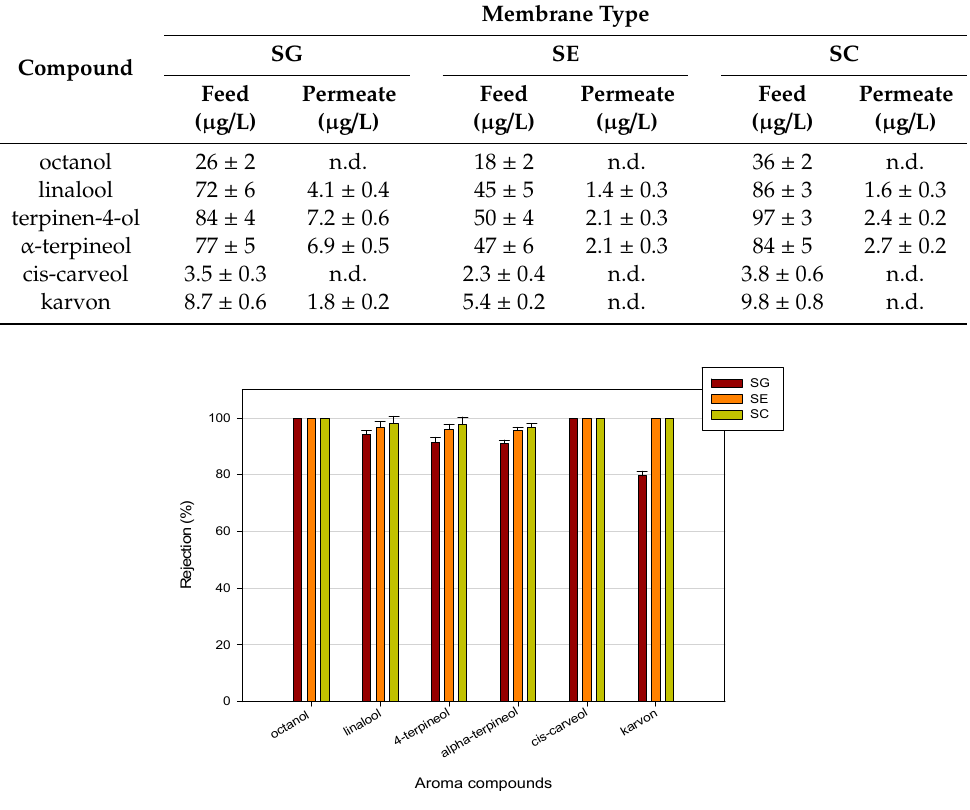
Figure 6. Rejection of RO membranes towards aroma compounds.